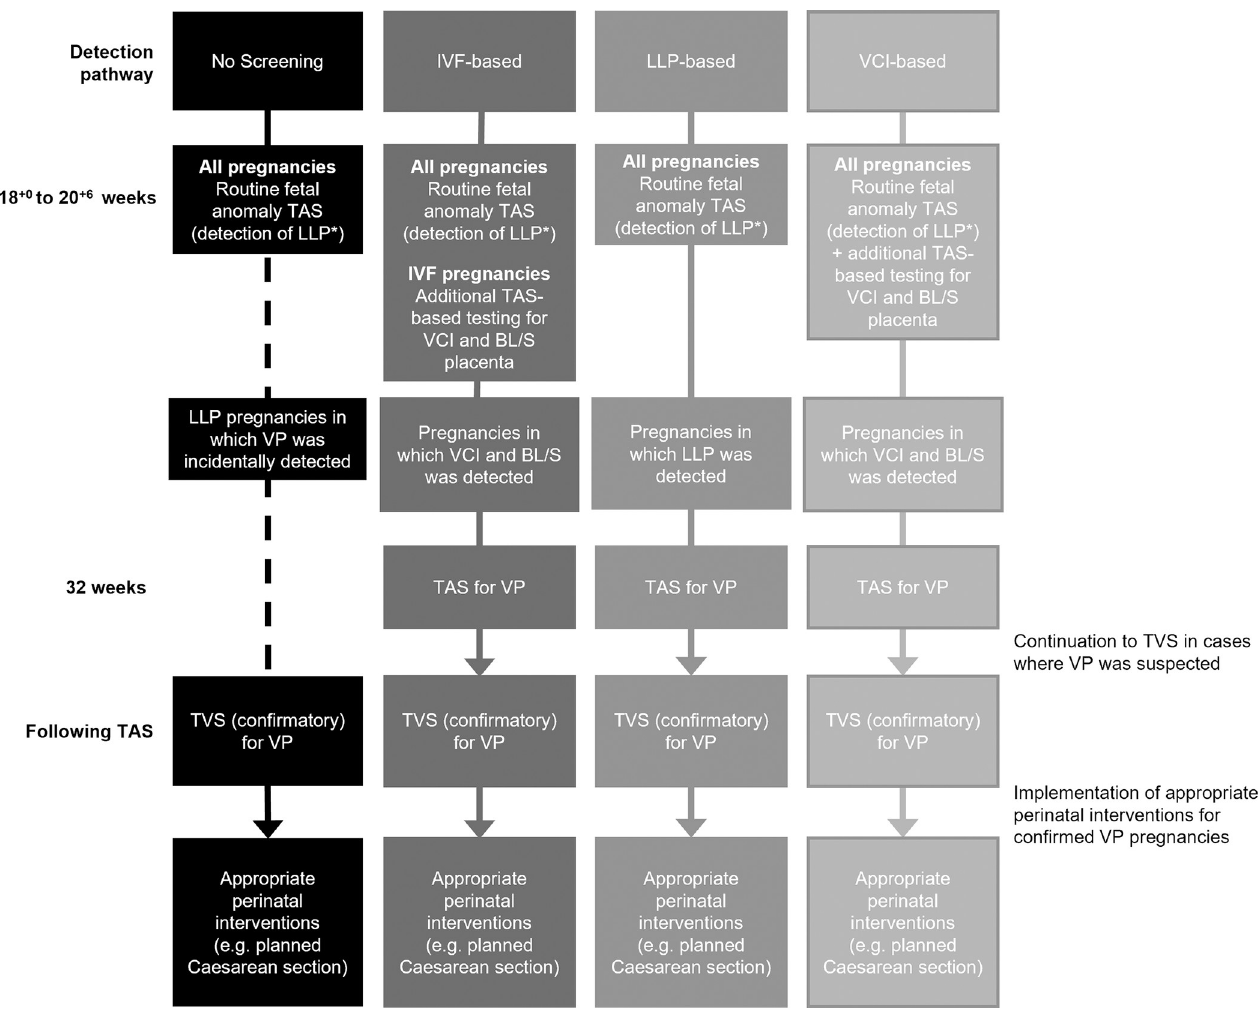
Fig 1. Modelled detection pathways. � Women with LLP defined by a placental edge that is 2 cm or less from the internal cervical opening. Abbreviations: BL/S, bilobed/succenturiate; IVF, in vitro fertilisation; LLP, low-lying placenta; TAS, transabdominal scan; TVS, transvaginal scan; VCI, velamentous cord insertion; VP, vasa